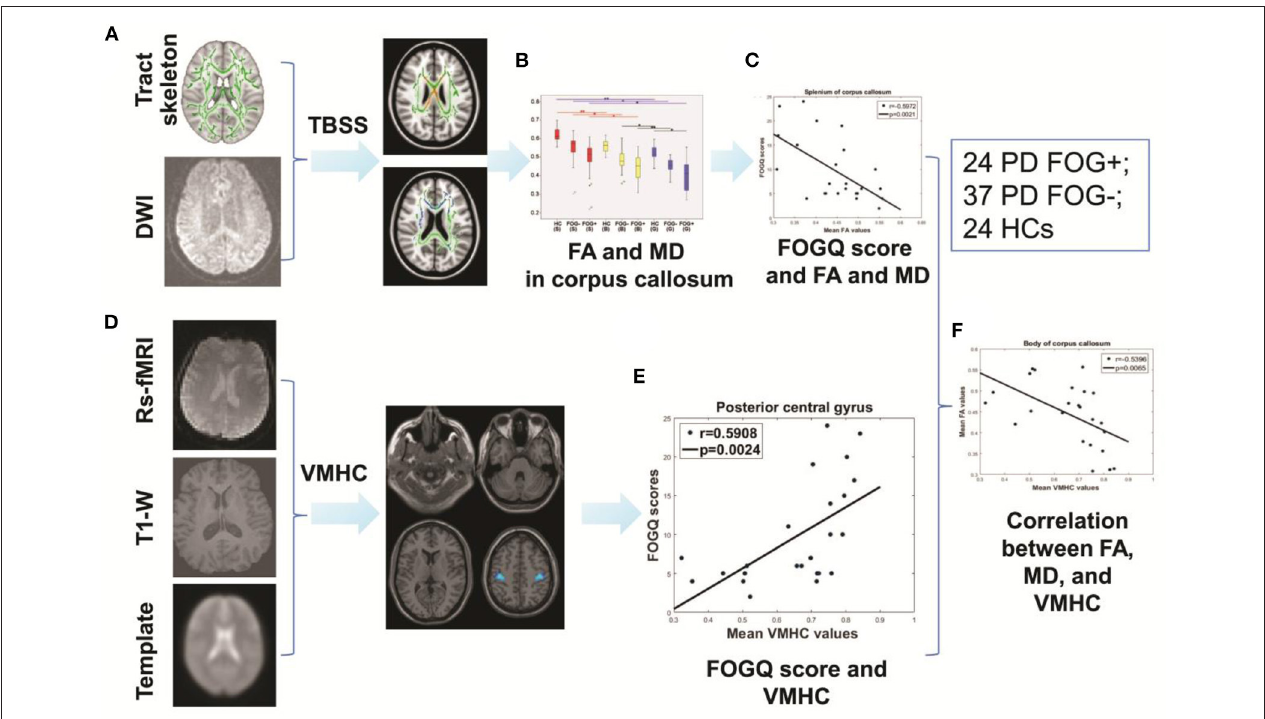
FIGURE 1 | Study protocol. (A) TBSS. (B) Intergroup comparisons of FA and MD in the CC. (C) Correlation between FA, MD, and FOGQ scores. (D) Analysis of VMHC. (E) Correlation between FOGQ scores and VMHC. (F) Correlation between FA, MD, and VMHC.